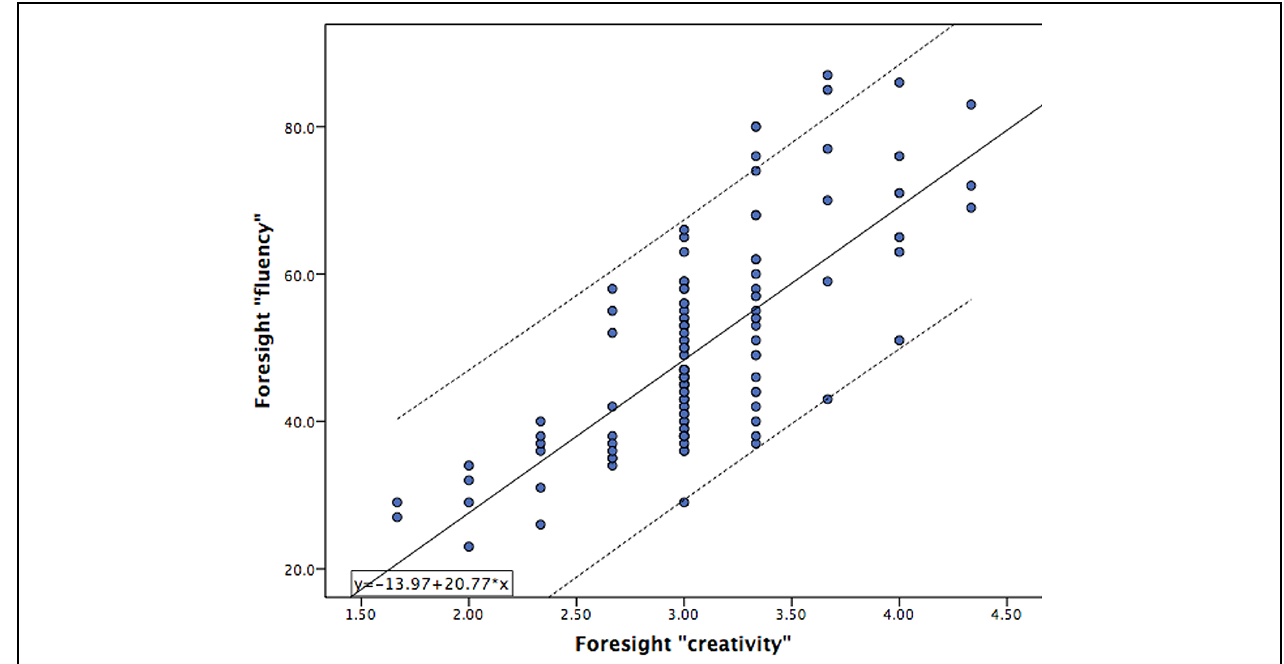
FIGURE 2 | Scatterplot of “fluency” measures from the Foresight task (y-axis) versus the “creativity” measure (x-axis) obtained from 246 subjects. Significant overlap in subject scores results in fewer than 246 individual points being observed on the graph.